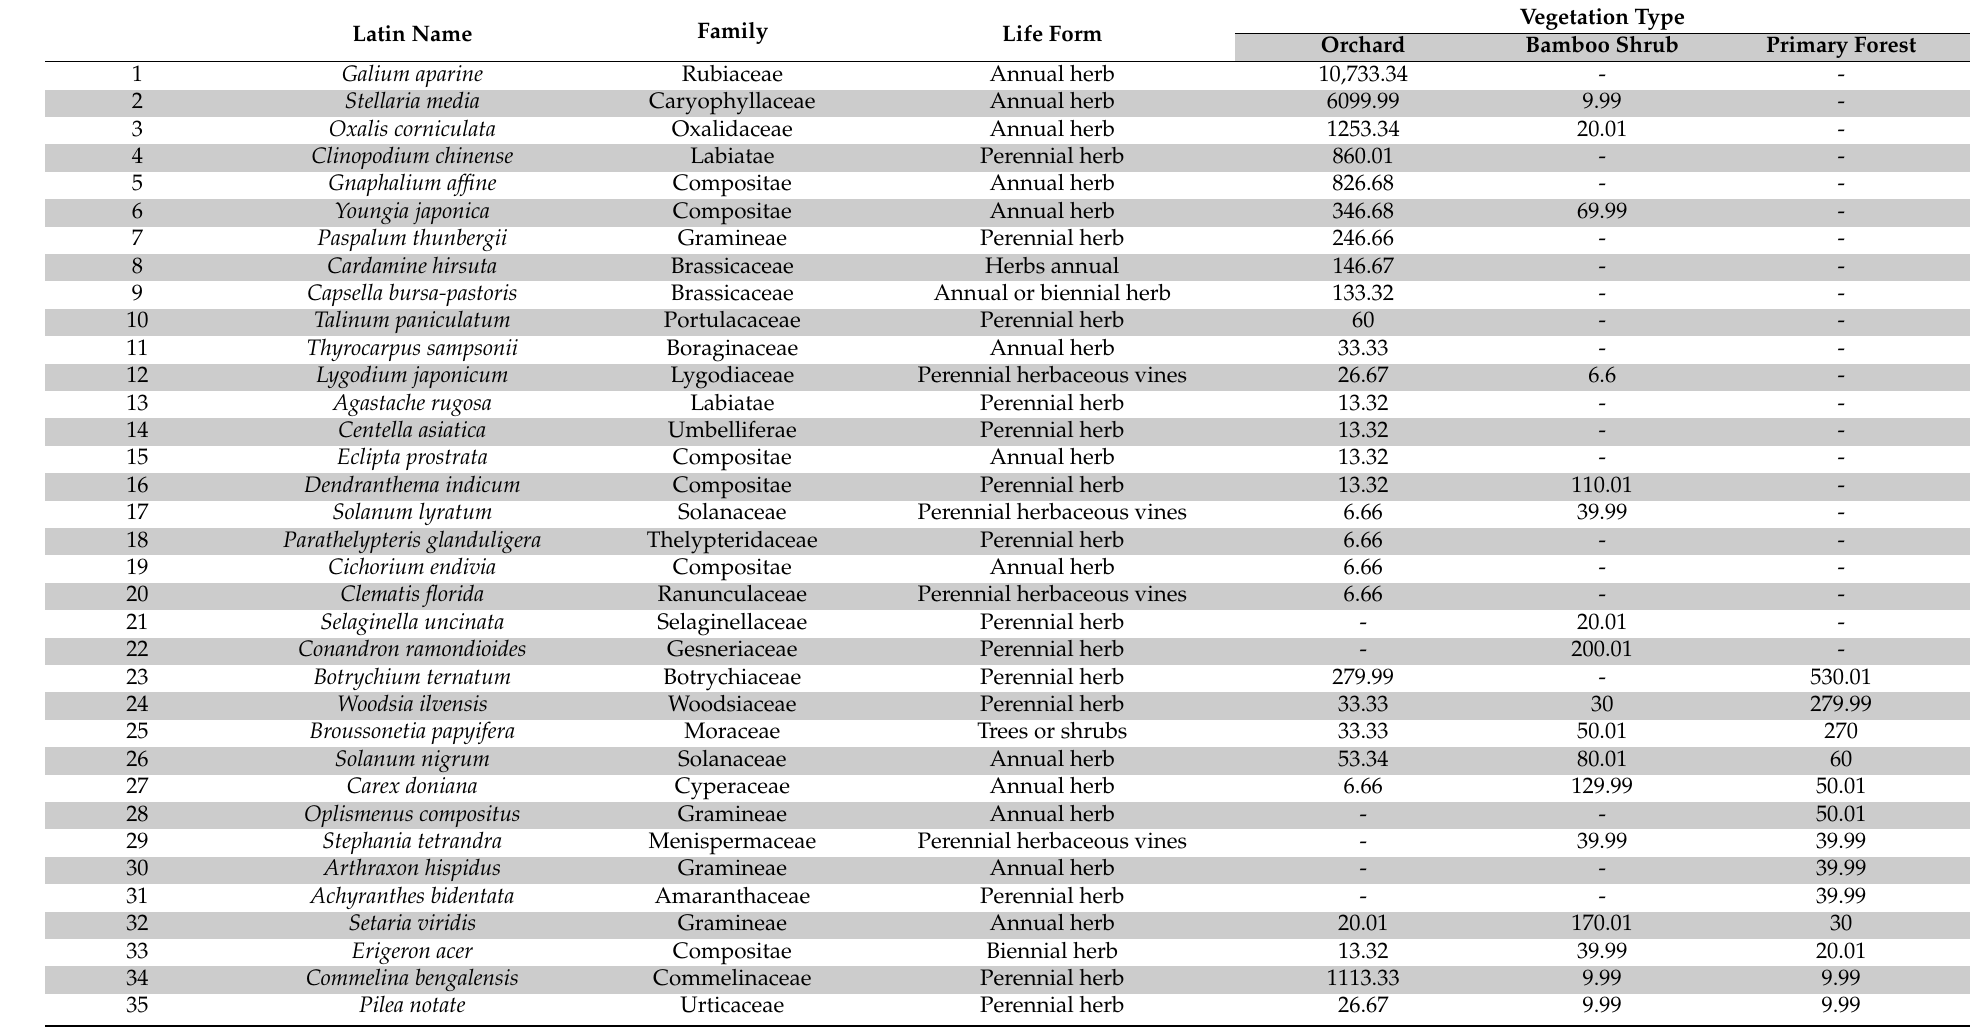
Table 3. Average soil seed bank density (m 2 ) of each plant species in different vegetation